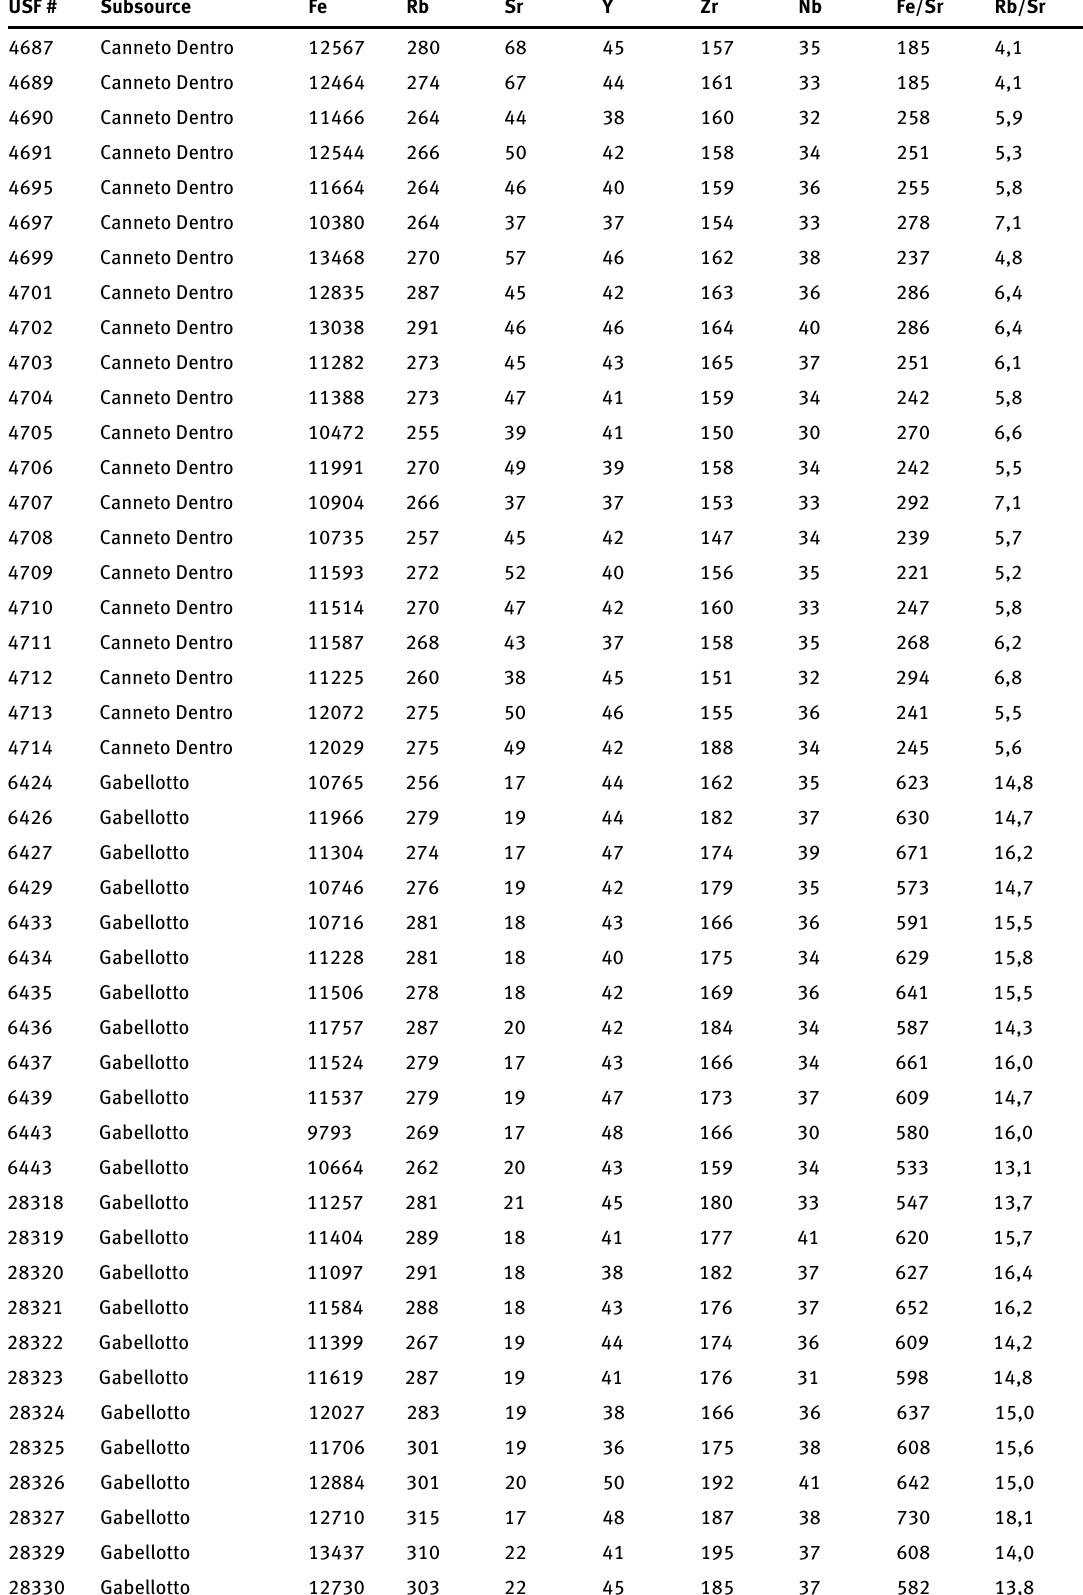
Table 3 . pXRF analyses of Lipari